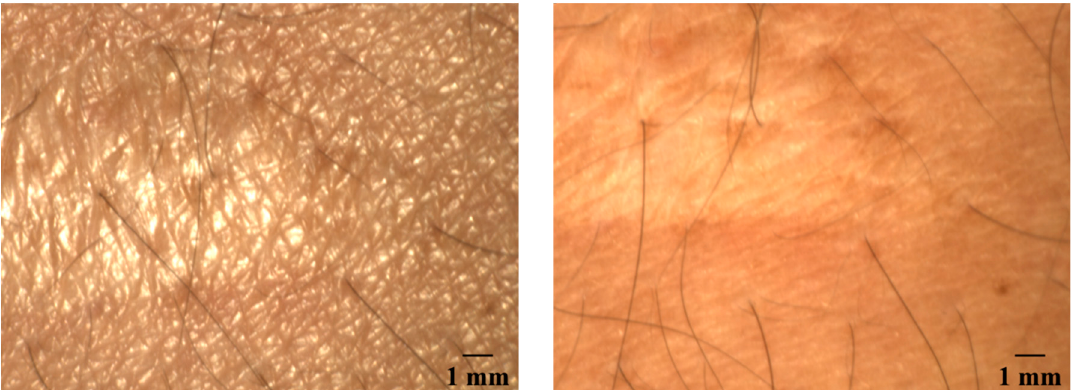
Figure 2. Image of a scar with parallel polarization ( left ) and cross-polarization ( right ). Due to the movement of the patient, the images do not show exactly the same part of the skin. The imaged area contains healthy skin and scar tissue. The scar tissue can be recognized by the larger facets in the left image and by the lighter color in the right image.